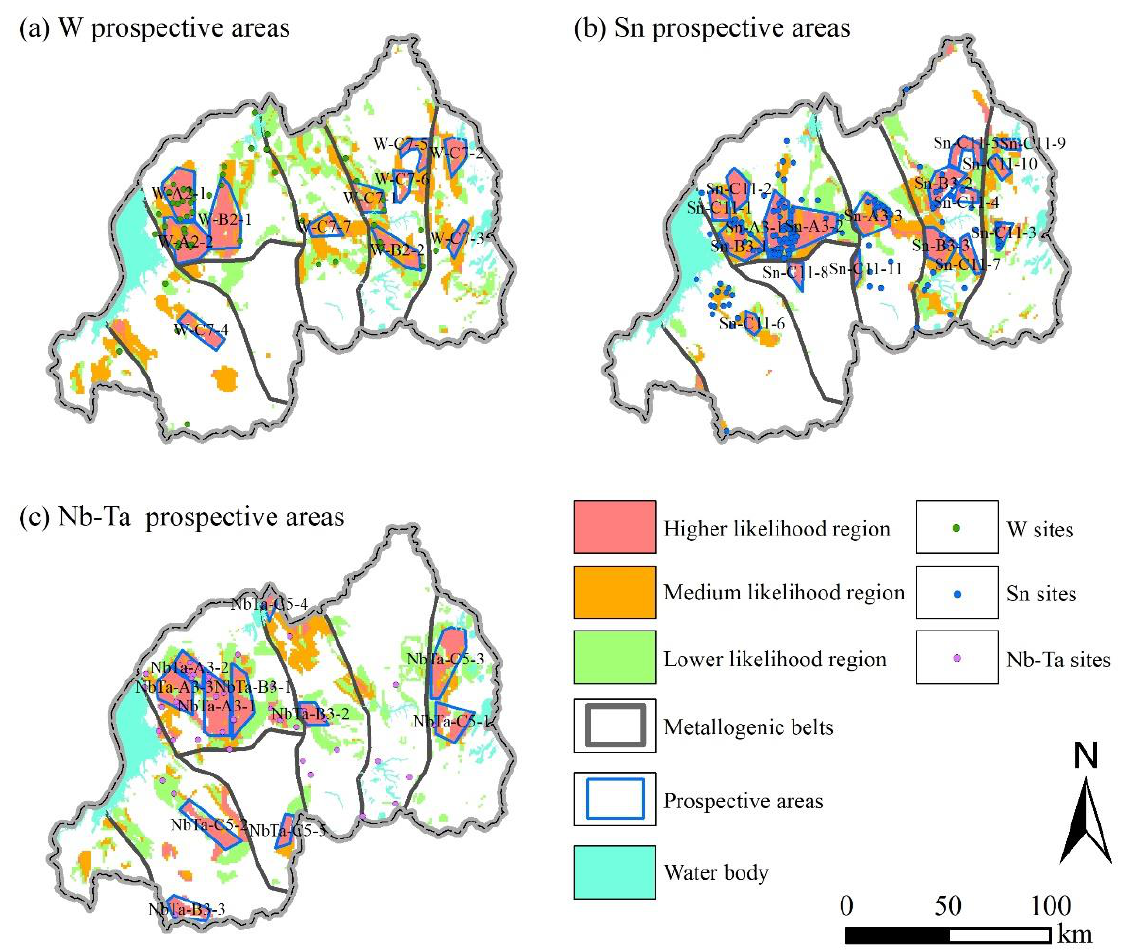
Figure 8. Prospective areas of W, Sn, and Nb-Ta in Rwanda. This figure was changed. ( a ) Prospective areas of W mineralization; ( b ) Prospective areas of Sn mineralization; ( c ) Prospective areas of Nb-Ta mineralization. Table 9. Attributes of W prospective areas.